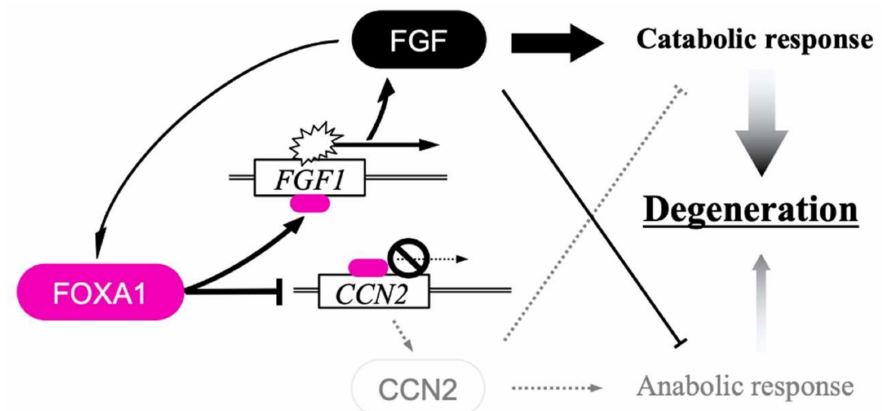
Figure 4. Integrated bidirectional regulation of FGF1 and CCN2 by the FGF signal in chondrocytes. Canonical FGF signaling emitted by FGF-1 induces FOXA1 to activate FGF1 and repress CCN2 simultaneously. Activation of FGF1 results in the formation of a positive feedback loop to amplify the outcome of this bipartite regulation. Synergistic cartilage degeneration would be induced by enhancing the catabolic effects of the FGF signal and repressing the anabolic effects of CCN2. Objects on FGF1 and CCN2 stand for transcriptional co-activator and co-repressor,